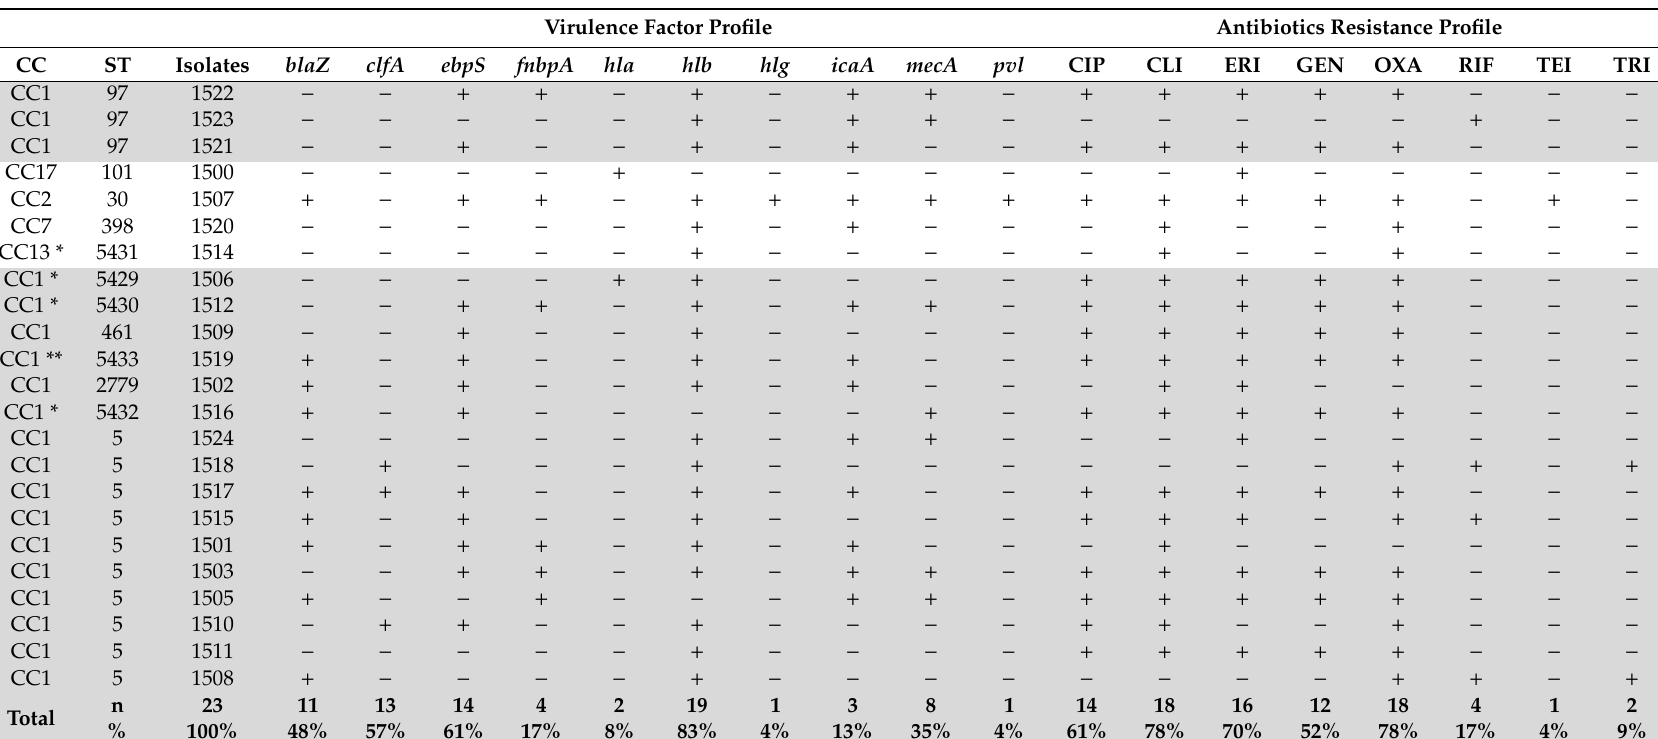
Table 2. Presence of virulence factor and antibiotic resistance profile of the 23 S. aureus , and their distribution in sequence type (ST) and clonal complex (CC). Blood samples were collected from patients treated at di ff erent public hospitals in S ã o Luis, Northeast Brazil, and submitted to antimicrobial susceptibility testing, as well as to the detection of several virulence and resistance